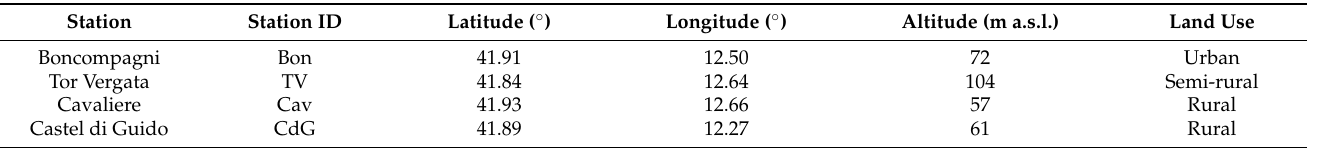
Table 1. Characteristics of the micrometeorological stations belonging to ARPA Lazio network used in the present